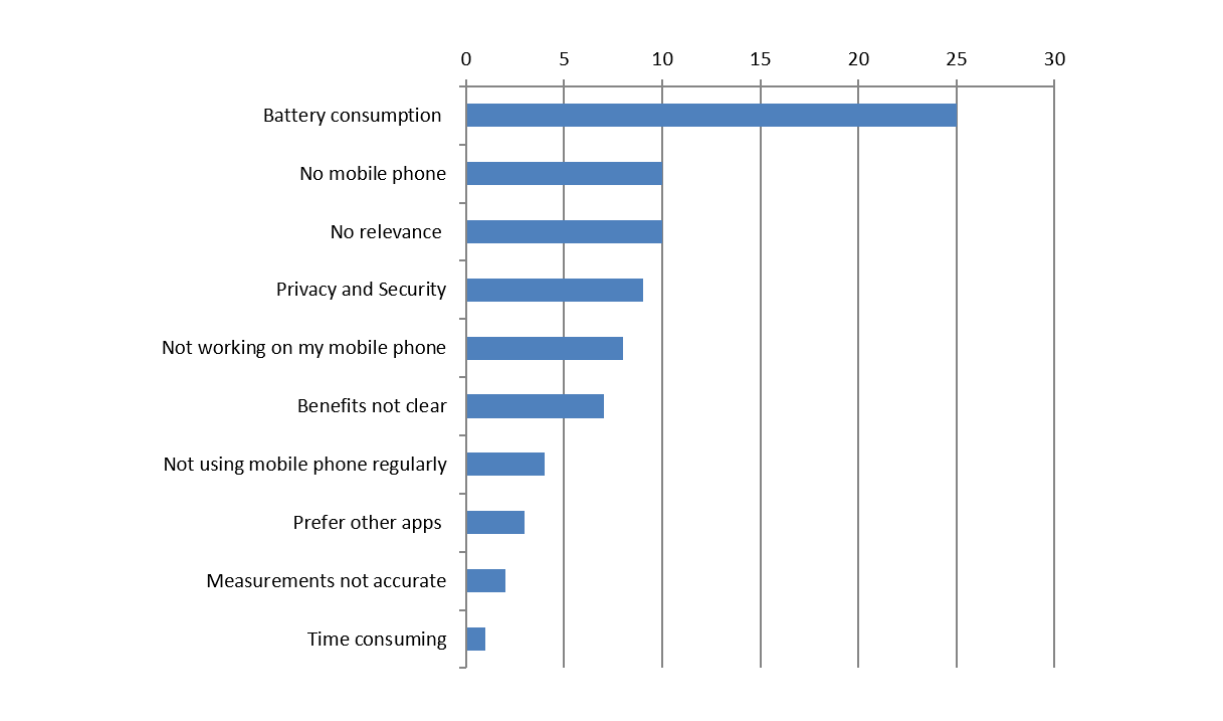
Figure 2. Main reasons (number of times mentioned) of 79 employees on why they declined to use Brightr and therefore, did not participate in the study.